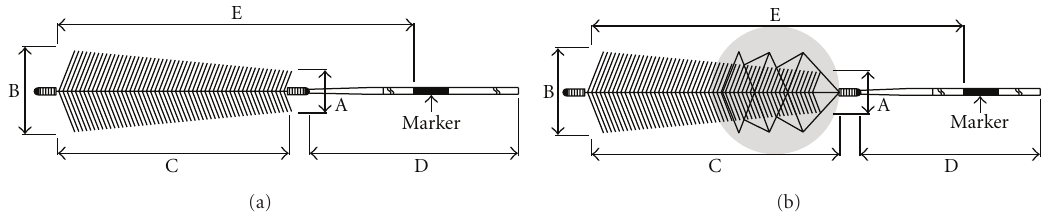
Figure 1: Schematic drawing of the phenox clot retriever ((a) pCR) and the phenox clot retriever cage ((b)